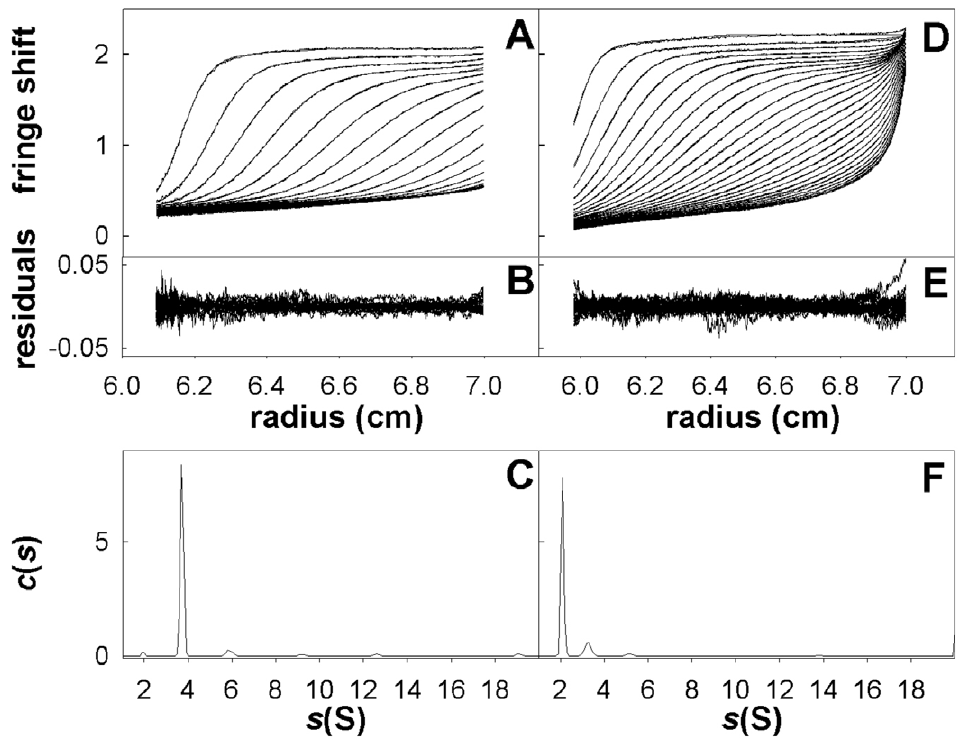
Figure 6. Ultracentrifugation experiments of EngA or GD1. Superposition of selected sedimentation profiles obtained at 278 nm and the corresponding fitted curves using continuous size distribution analysis for EngA ( A ) and GD1 ( D ). Superposition of the residuals ( B , EngA; E , GD1). The fitted curves were used to calculate the sedimentation coefficient distribution of the enzyme, c(s) ( C , EngA; F , GD1).